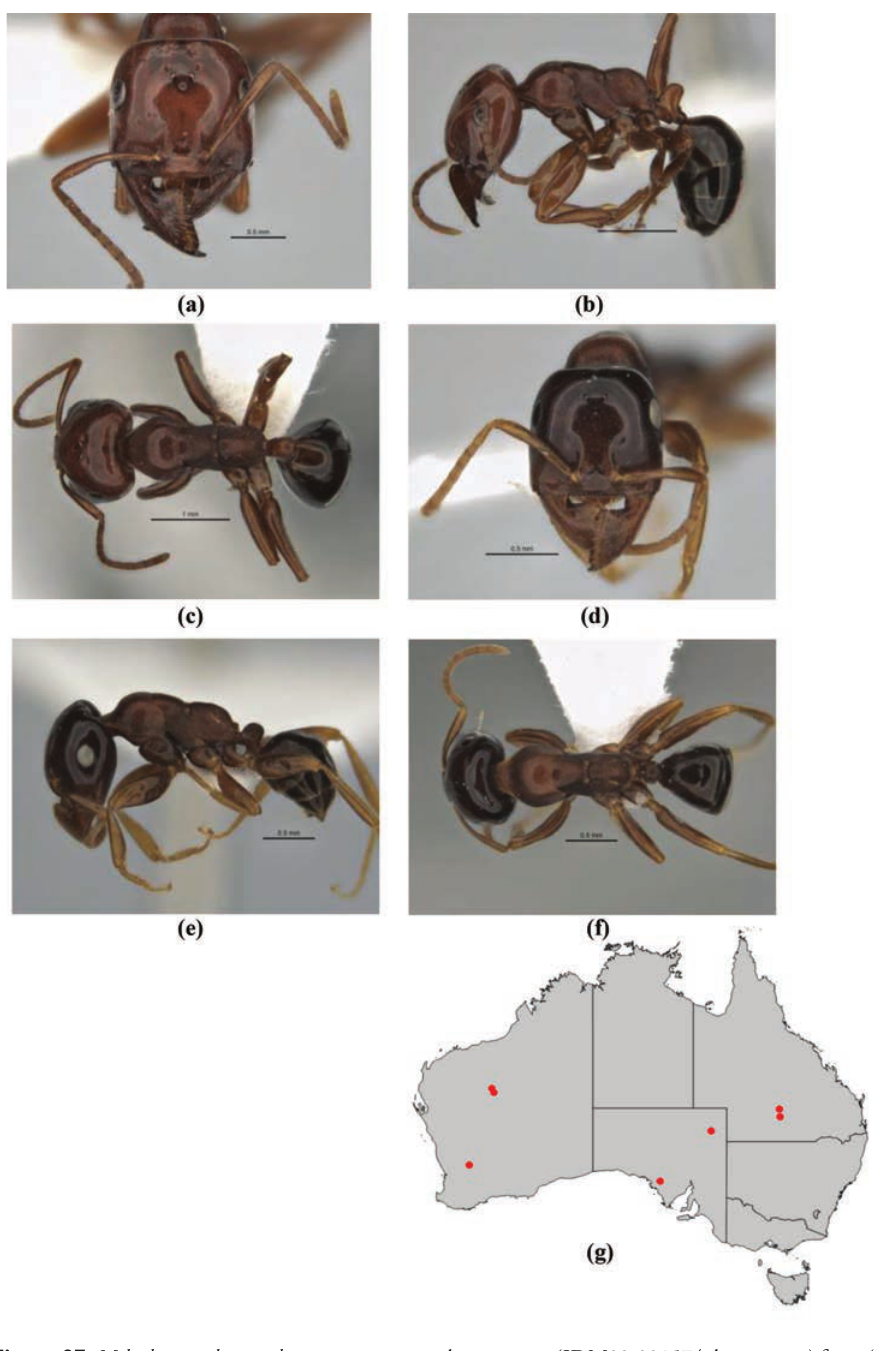
Figure 97. Melophorus pelecygnathus sp. n.: major worker paratype (JDM32-001574–bottom ant) frons ( a ), profile ( b ) and dorsum ( c ); minor worker holotype (JDM32-001575–top ant) frons ( d ), profile ( e ) and dorsum ( f ); distribution map for the species ( g ). Low resolution scale bars: 1 mm ( b, c ); 0.5 mm ( a, d–f